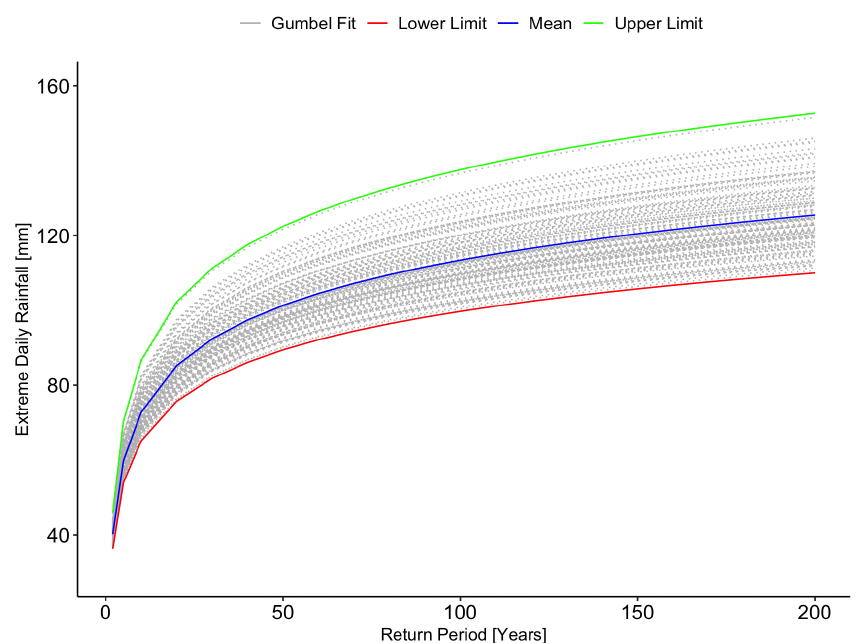
Figure 6. Return period curves derived from Gumbel fittings in all pixels across the study area (grey lines), with the relationship curves for the mean extreme daily rainfall (blue), the maximum (green), and the minimum (red).